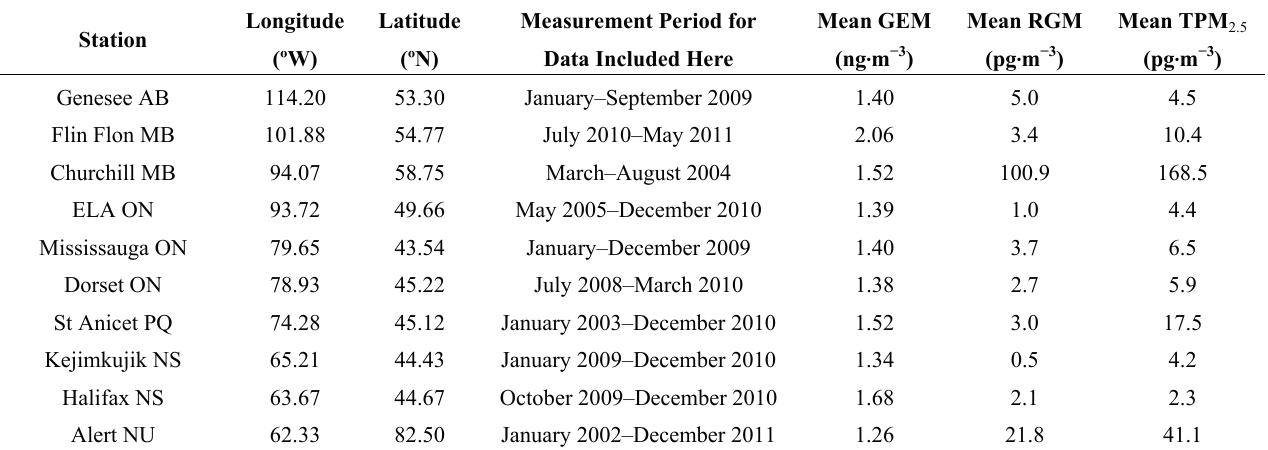
Table 2. Stations measuring speciated mercury (GEM, RGM, and TPM mean values over the entire measurement period.